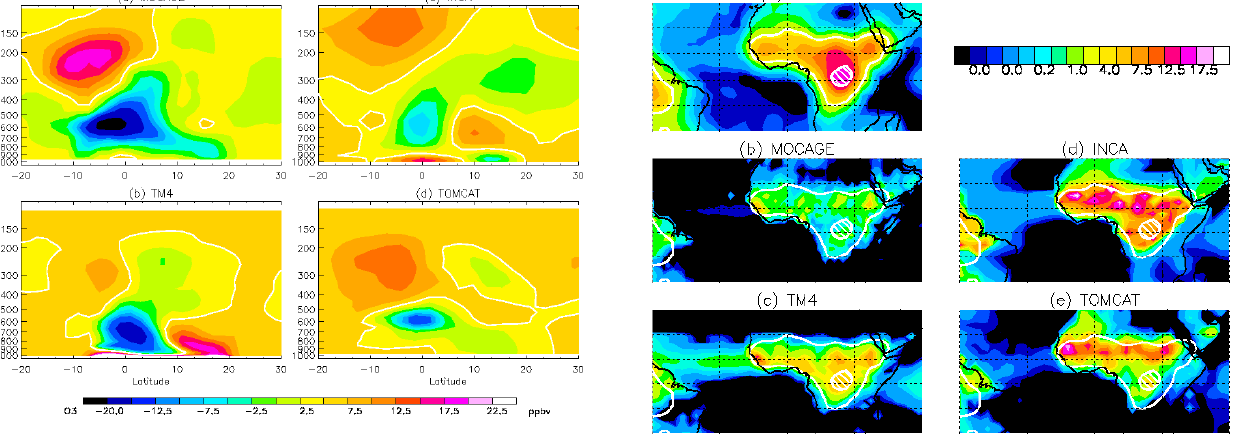
Fig. 11. August lightning flash frequencies in 100xflashes/km2/day (a) climatology from 10 years (1995–2005) LIS observations and simulations by (b) MOCAGE (c) TM4 (d) INCA and (e) p- TOMCAT. White contours indicate lightning flash frequencies of 0.04 and 0.15flashes/km 2 /day as observed by LIS, with values above 0.15 hatched